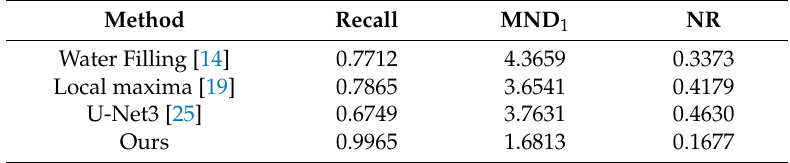
Table 1. Performance of various human detection methods on our proposed